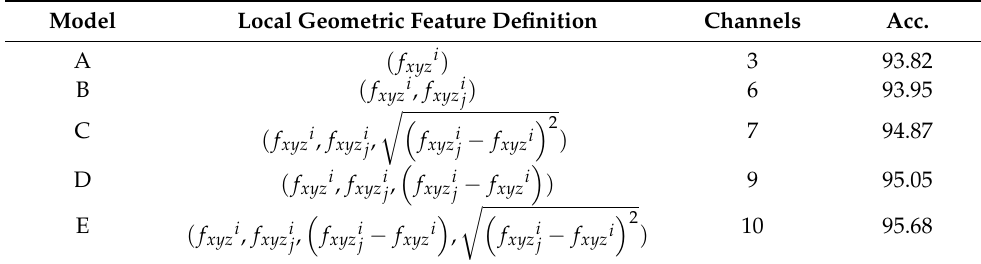
Table 5. The results (%) of five forms of encoding local geometric features. model A applies only the coordinates of the point x i as geo; model B uses the coordinates of the point x i and its neighboring points x i ; model C adds the Euclidean distance to model B; model D adds the relative distance to j model B; model E contains all spatial information mentioned above.